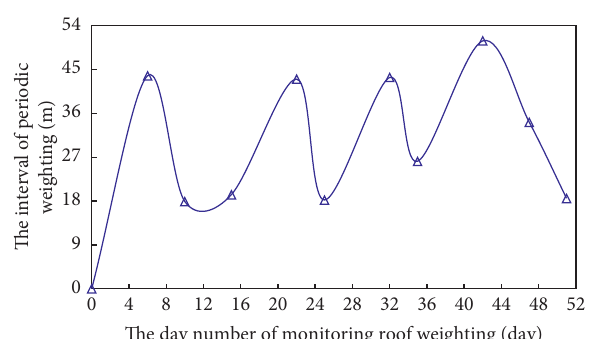
Figure 1: The weighting interval of main roof in full-mechanized coal caving face with large mining